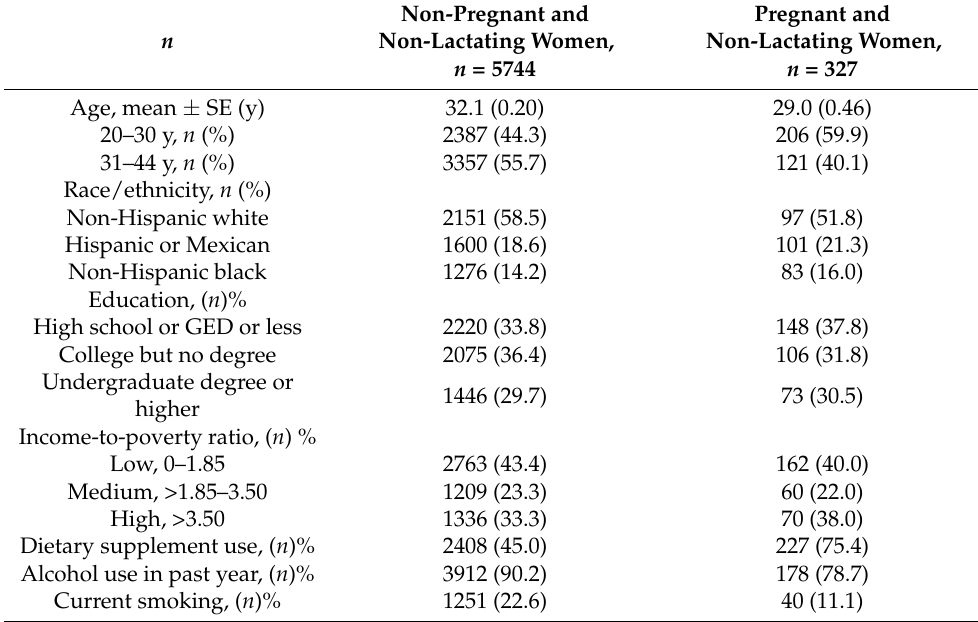
Table 1. Study population characteristics, women of childbearing age (20–44